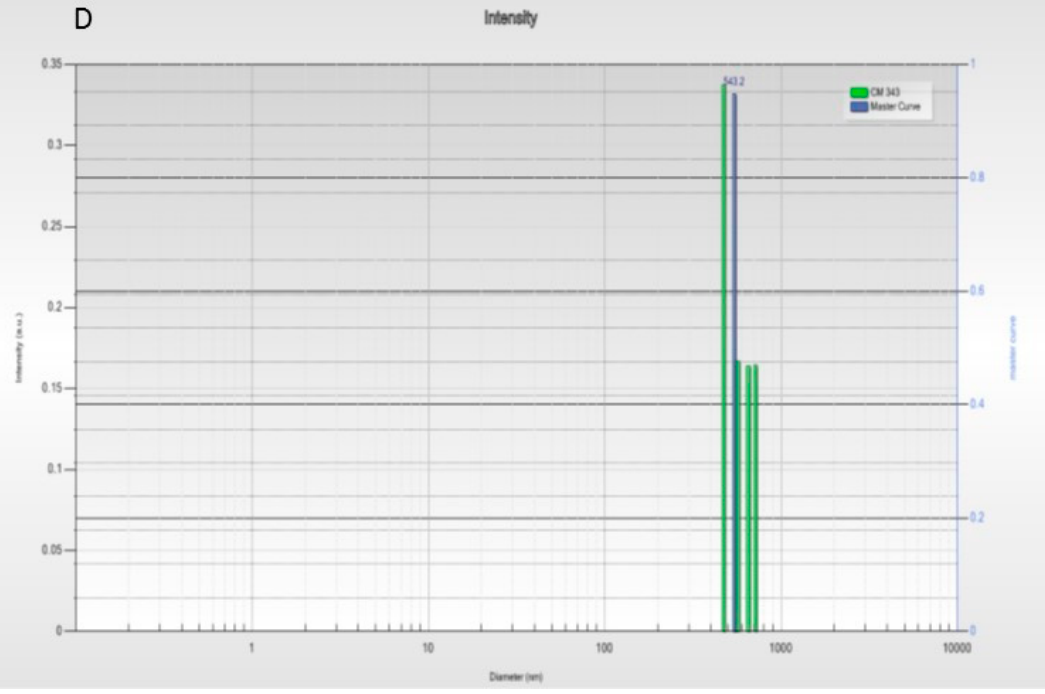
Figure 2. ( A ) TEM image of NaYF 4 : Yb 3+ -Er 3+ @Ethane scale bar 2 µm. ( B ) TEM of NaYF 4 : Yb 3+ -Er 3+ @Ethane, scale bar 200 nm. Red arrows show the embedded upconversion nanoparticles. ( C ) Luminescence spectrum of NaYF 4 : Yb 3+ -Er 3+ @Ethane upon excitation at 973 nm ( D ) DLS of NaYF 4 : Yb 3+ -Er 3+ @Ethane, in EtOH.